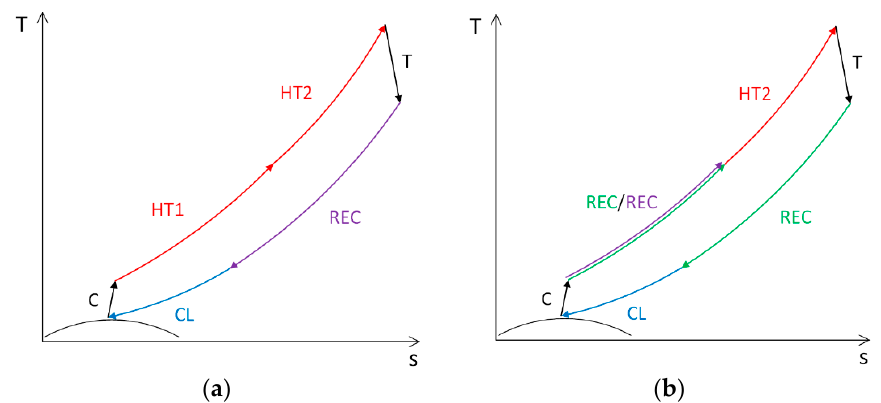
Figure 4. Decomposition of the partial heating s-CO 2 cycle into two elementary thermodynamic cycles: ( a ) First elementary cycle (topping); ( b ) Second elementary cycle.